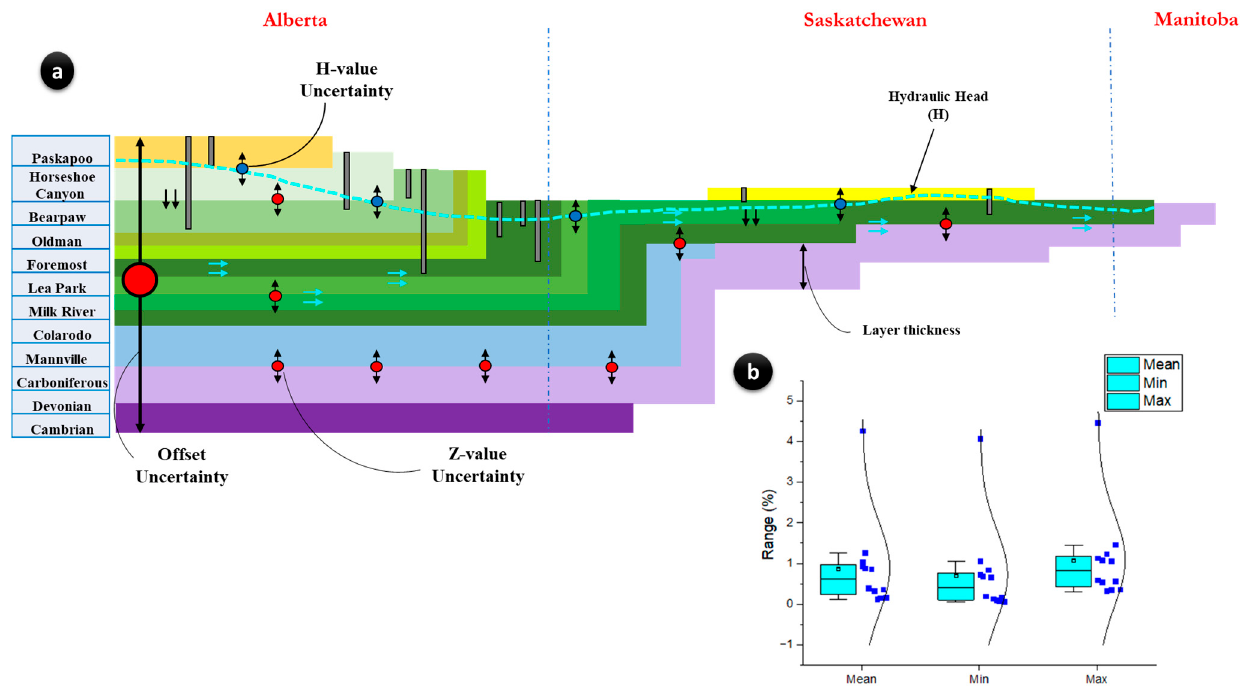
Figure 6. ( a ) Different sources of uncertainty taken into consideration in the modeling work and ( b ) errors in the hydrodynamic parameters.